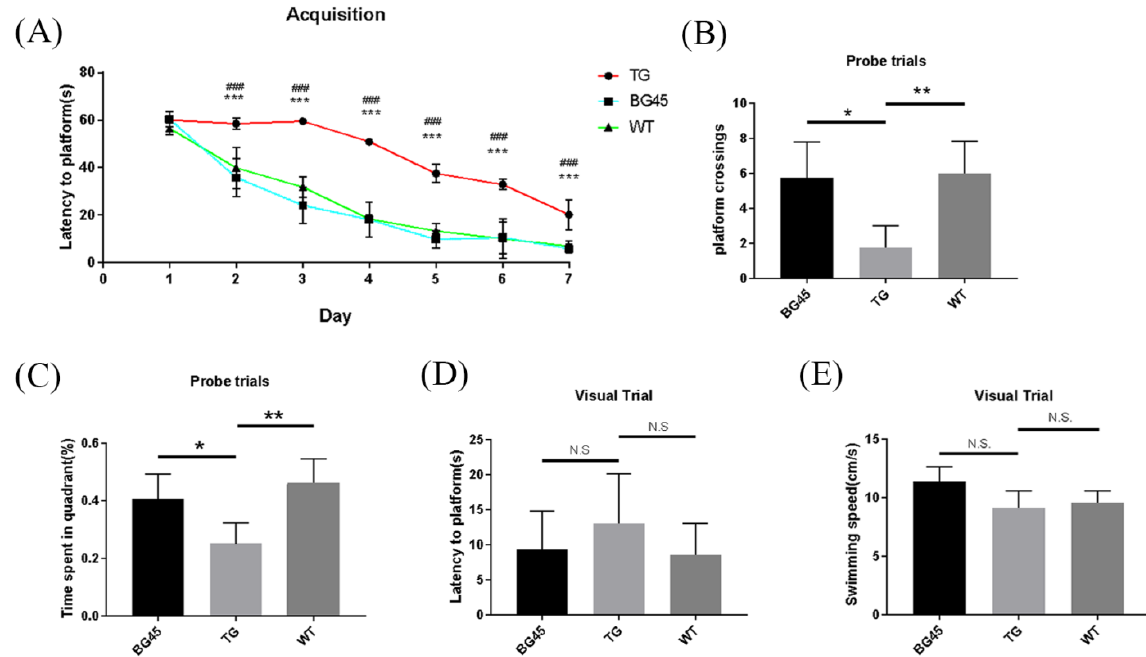
Figure 3. BG45 alleviated cognitive impairment in APP/PS1 transgenic mice. ( A ) Latency to platform (acquisition trial), ( B ) platform crossing (probe trial), ( C ) time spent in the target quadrant (probe trial), ( D ) latency to platform (visual trial), and ( E ) swimming speed. ### p < 0.001: TG vs. BG45; * p < 0.05, ** p < 0.01, *** p < 0.001: TG vs. WT.